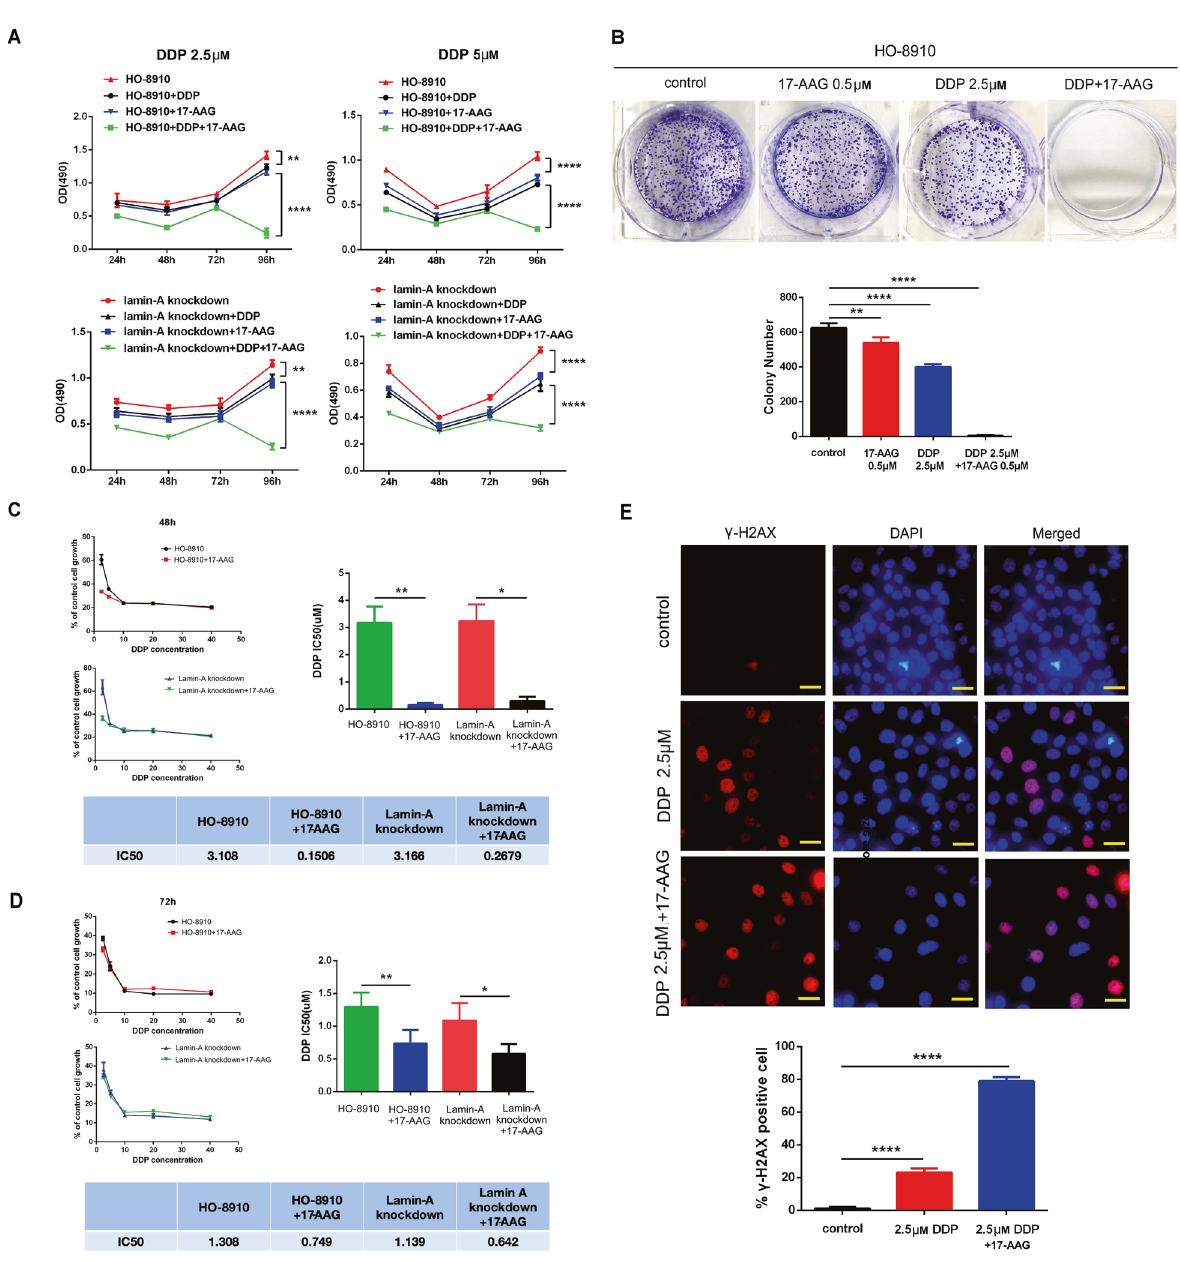
Fig. 5 Combination of 17-AAG and DDP can ef fi ciently inhibit the growth of ovarian cancer cells in vitro. A HO-8910 cells or stable lamin-A knockdown cells were treated with DDP (2.5 and 5 μ M) or 17-AAG (0.5 μ M) for 96 h, and cell viability was analyzed by CCK-8 assay. B Clonogenic assay: representative images of plates and colony numbers of different groups. Colonies containing more than 50 cells were counted. C and D Analysis and quanti fi cations of IC50 value in HO-8910 cells (or stable lamin-A knockdown cells) treated with different concentrations of DDP (or combined with 17-AAG) for 48 h C and 72 h D . E Representative images of γ -H2AX foci and quantitative results of γ - H2AX positive cells. Scale bars, 50 μ m. All the experiments were repeated three times. All the error bars indicated means ± SD. Statistical signi fi cance was concluded at * p < 0.05; ** p < 0.01; *** p <